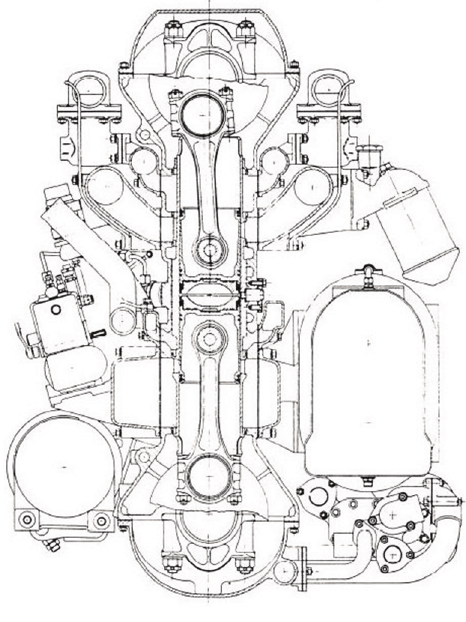
Fig. 2. Leyland L60 two-stroke opposed piston engine